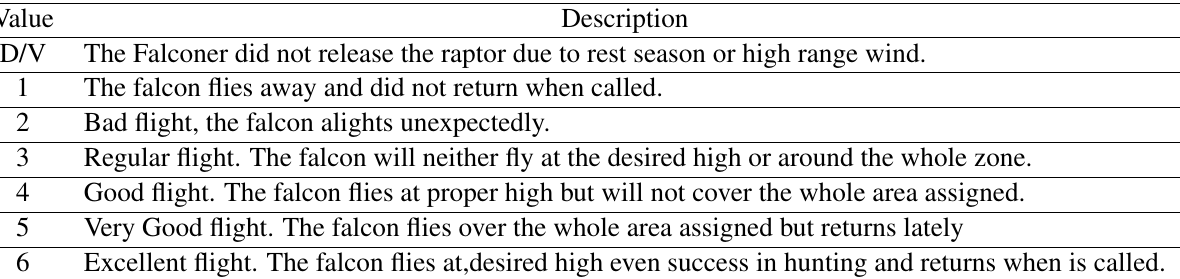
Table 2 The falconer evaluation